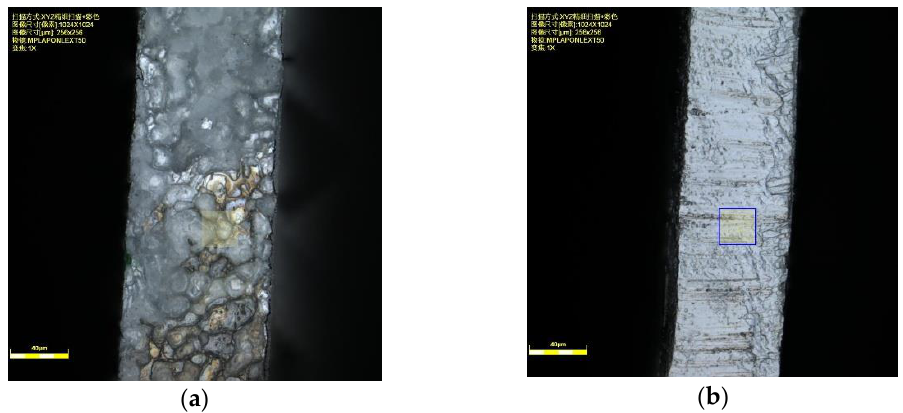
Figure 4. Photographs of two sides of the machined slit: ( a ) rough side of the slit, Ra 1.427 μm; ( b ) fine side of the slit, Ra 0.391 μm.